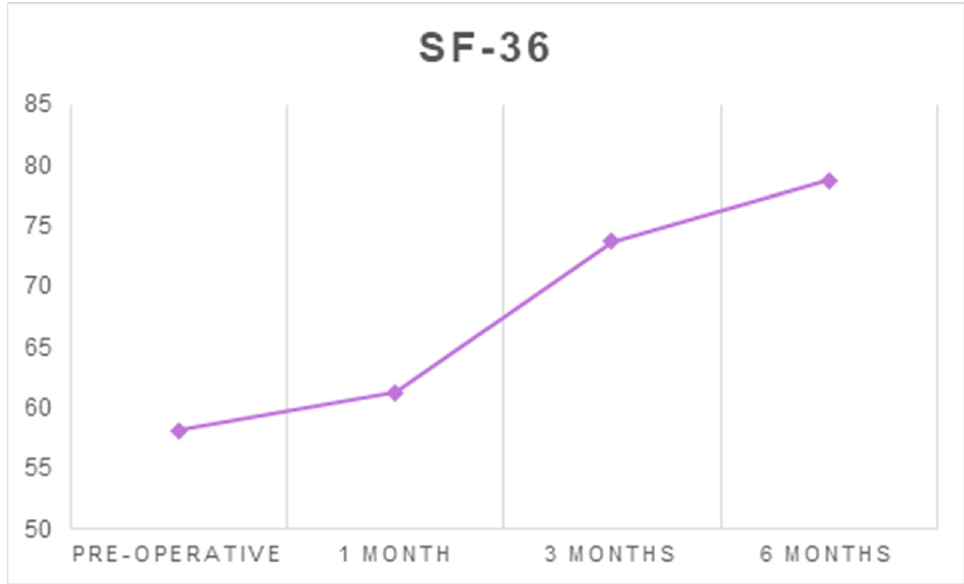
Figure 2. The average scores of SF-36 at each follow-up timepoint. The mean SST score increased from 3.41 ± 2.73 before surgery to 8.62 ± 2.65 at six months after surgery ( p < 0.001) (Tables 1 and 2, Figure